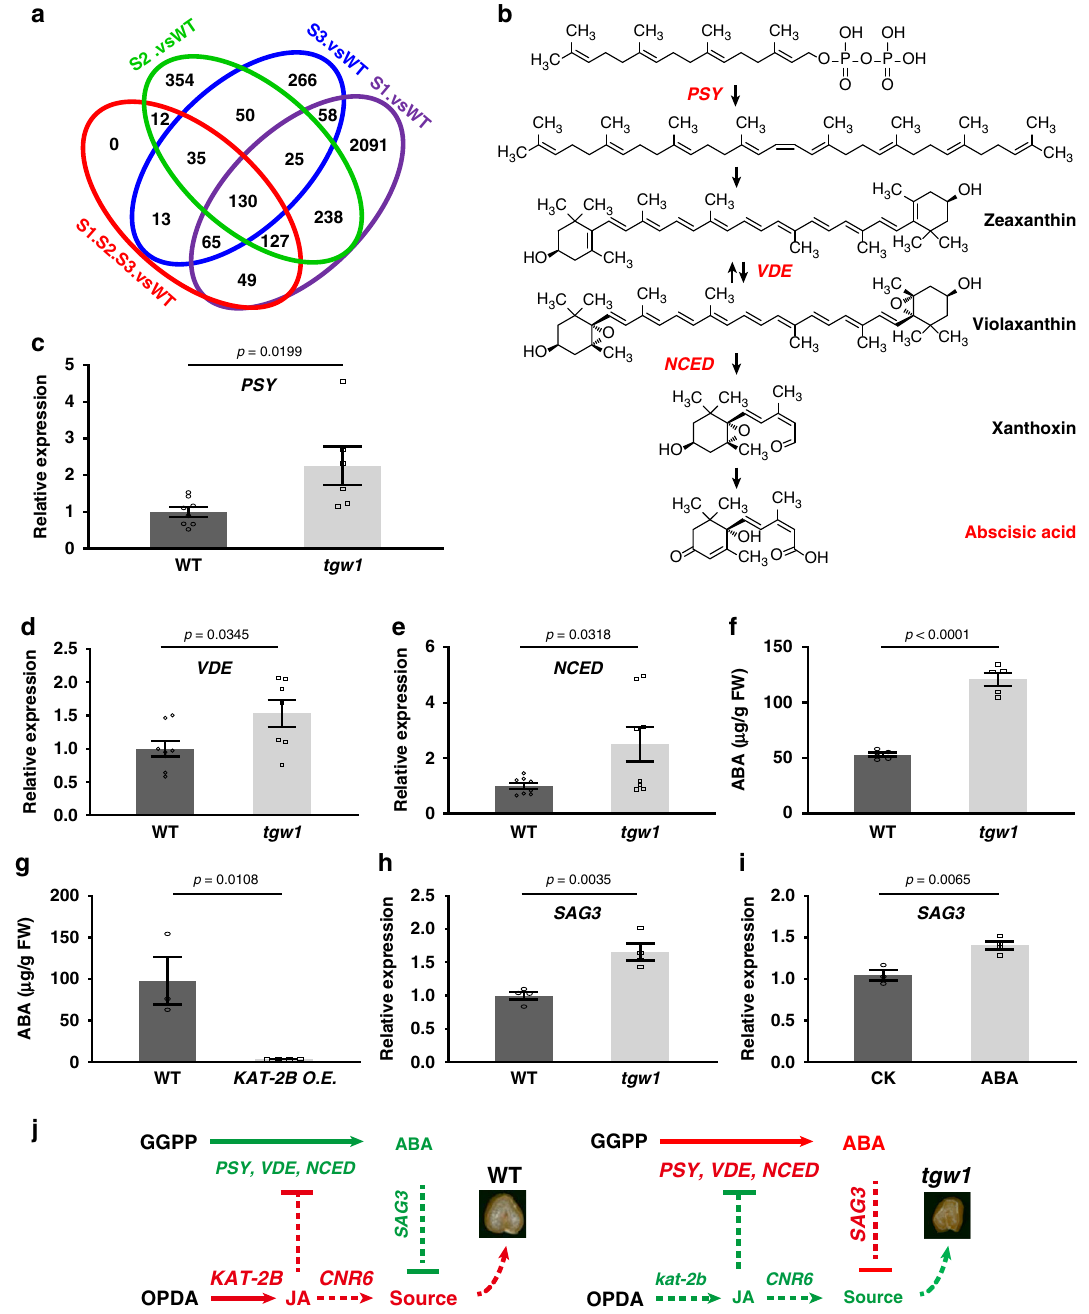
Fig. 5 Regulation of ABA synthesis in tgw1 . a Venn diagram representation of differential expression genes between WT and the tgw1 backcrossed mutant. b Schematic representation of the ABA synthesis pathway. PSY , VDE , and NCED were upregulated in tgw1 mutant. c – e Relative expression level of PSY , VDE , and NCED in WT and tgw1 mutant from at least four independent biological samples. f Quanti fi cation of ABA in WT and tgw1 mutant. n = 5. g Quanti fi cation of ABA in WT ( n = 3) and transgenic plants ( n = 4). h Relative expression level of senescence-associated gene 3 ( SAG3 ) in WT and tgw1 mutant. n = 4. i Expression change of SAG3 upon 80 μ M ABA treatment. n = 4. j A predicted working model for GW regulation in WT or tgw1 mutant. Red, upregulated. Green, downregulated. WT and tgw1 grains were cross-dissected to show grain width. Data in c – i are represented as mean ± SEM, and p values are indicated by two-tailed unpaired t test. Source data underlying Fig. 5a and c – i are provided as a Source Data fi